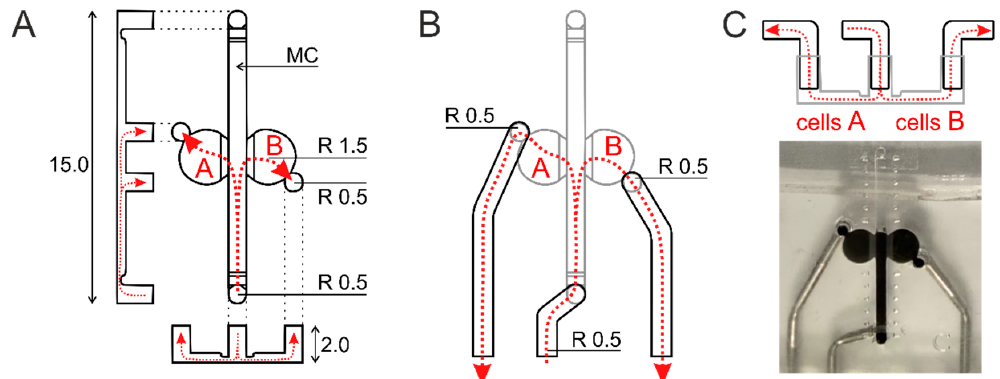
Figure A1. Microfluidic chip and application insert. ( A ) Blueprints of the microfluidic chip (cross sections and top view). ( B ) Top view blueprint of application insert–chip assembly. ( C ) Cross-section of application insert–chip assembly and top view photograph of the assembly.